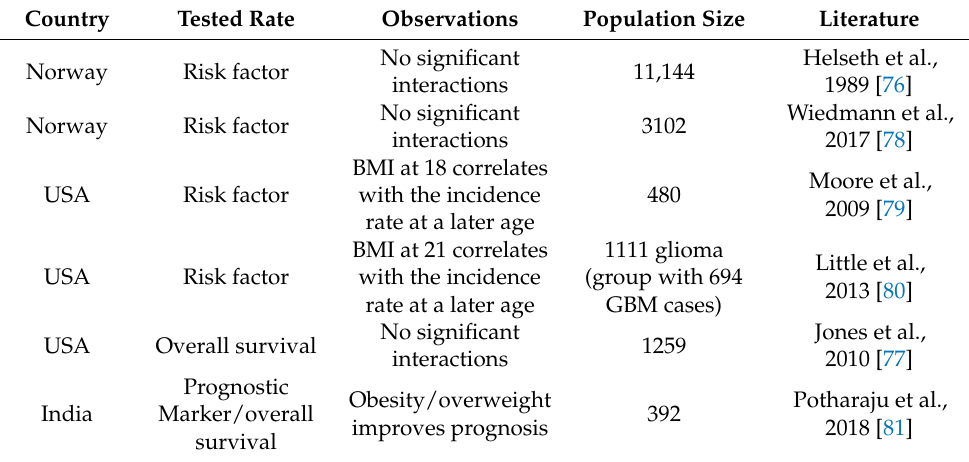
Table 3. Summary of studies on the association of BMI with the risk of GBM. Country Tested